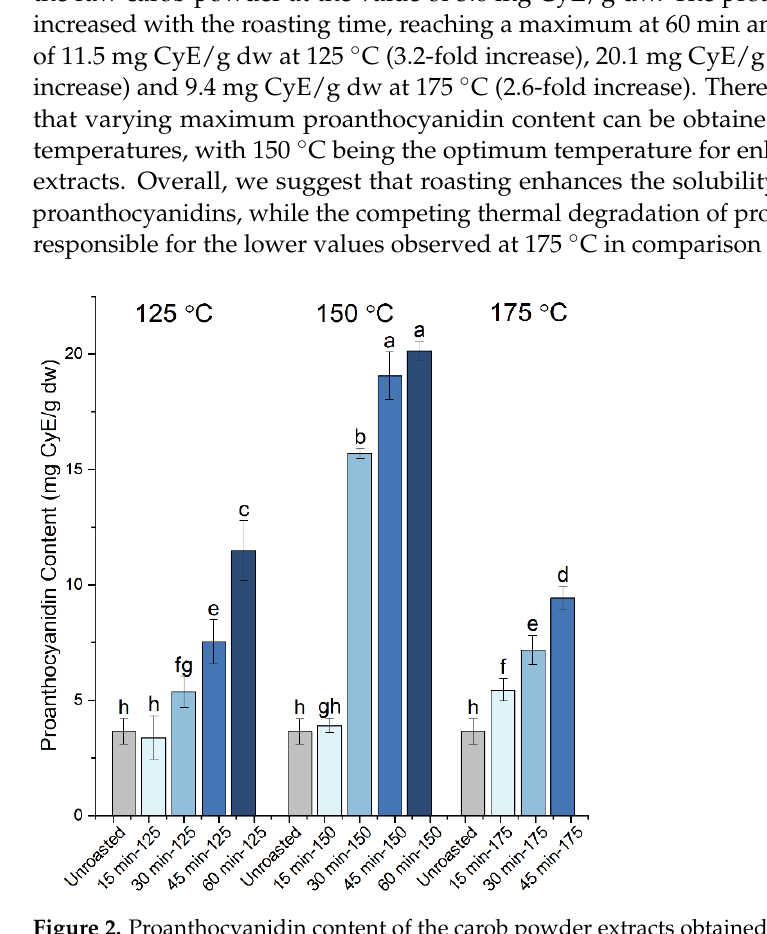
Figure 2. Proanthocyanidin content of the carob powder extracts obtained prior to (unroasted) and after the roasting of kibbles at 125 °C (for 15, 30, 45 and 60 min), 150 °C (for 15, 30, 45 and 60 min) and 175 °C (for 15, 30 and 45 min). The different letters show the statistically significant differences according to Tukey’s HSD test at p < 0.05.